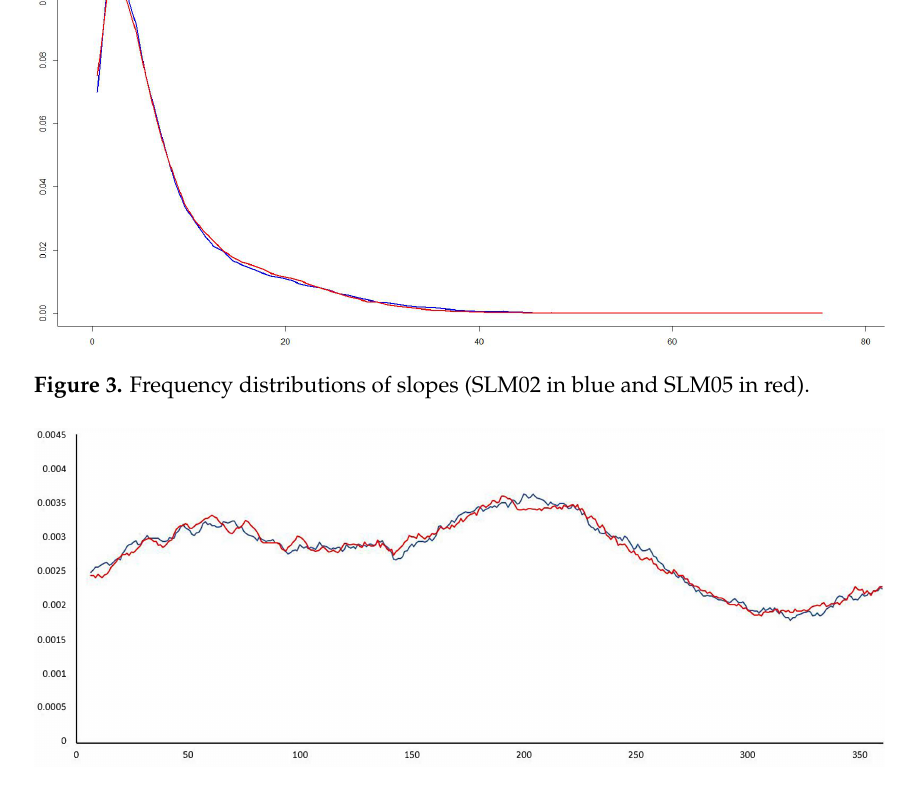
Figure 4. Frequency distribution of aspects (ASM02 in blue and ASM05 in